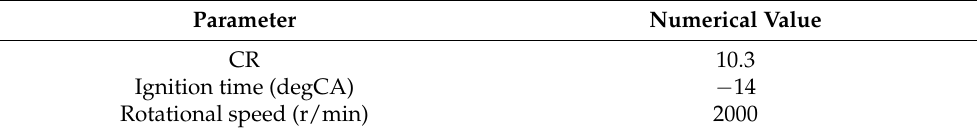
Table 8. Knock operation conditions.